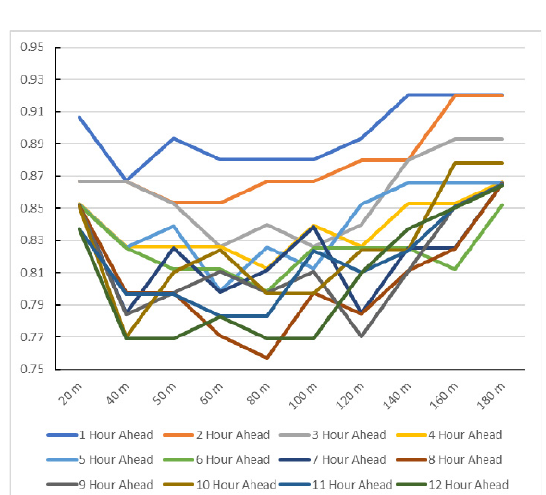
Figure 7. Predictability in relation to the future hours